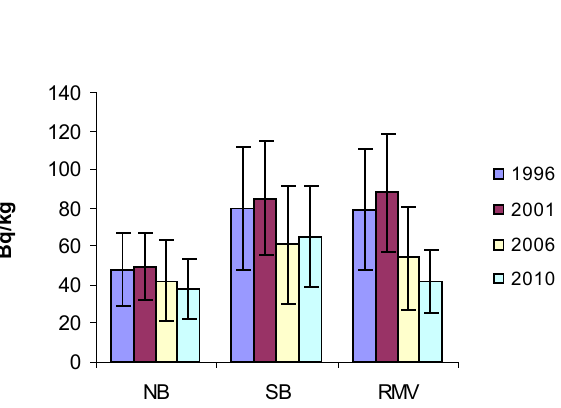
Figure 2 : 238 U activity concentration in soil samples from different regions (1996-2010).